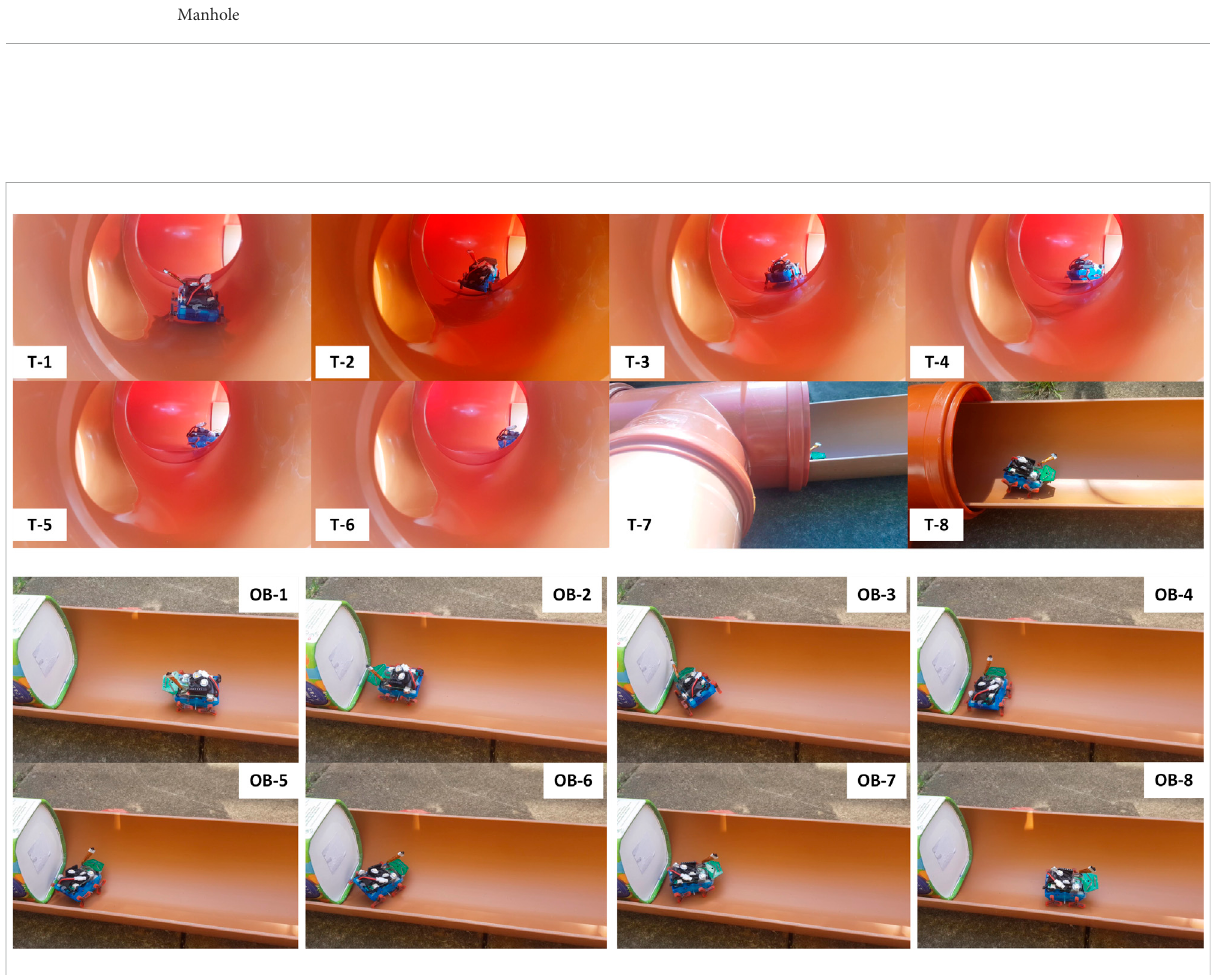
FIGURE 9 Successful detection, decision making and maneuvers of the Joey robot at T-junction (T-1 to T-8, top two rows) and large obstacle (OB-1 to OB-8, bottom two rows) in autonomous pipe exploration.